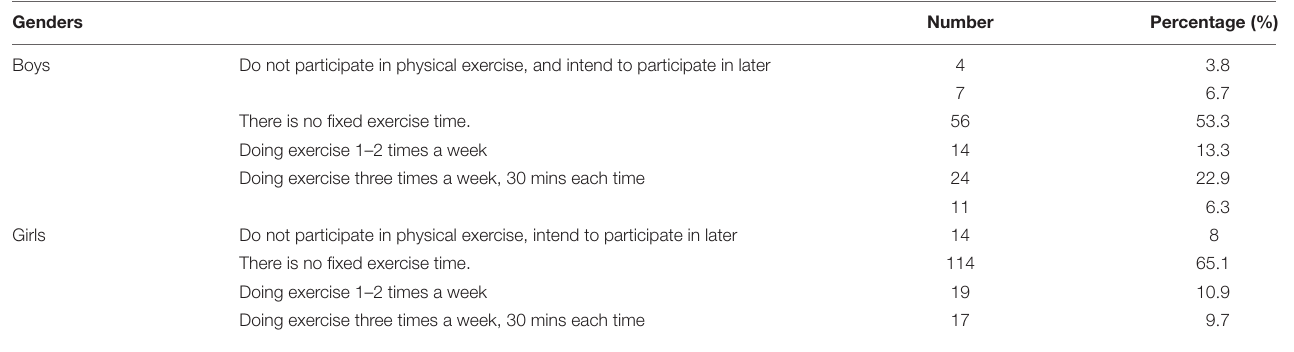
TABLE 6 | Distribution characteristics of physical exercise of primary and middle school students in Tianjin.